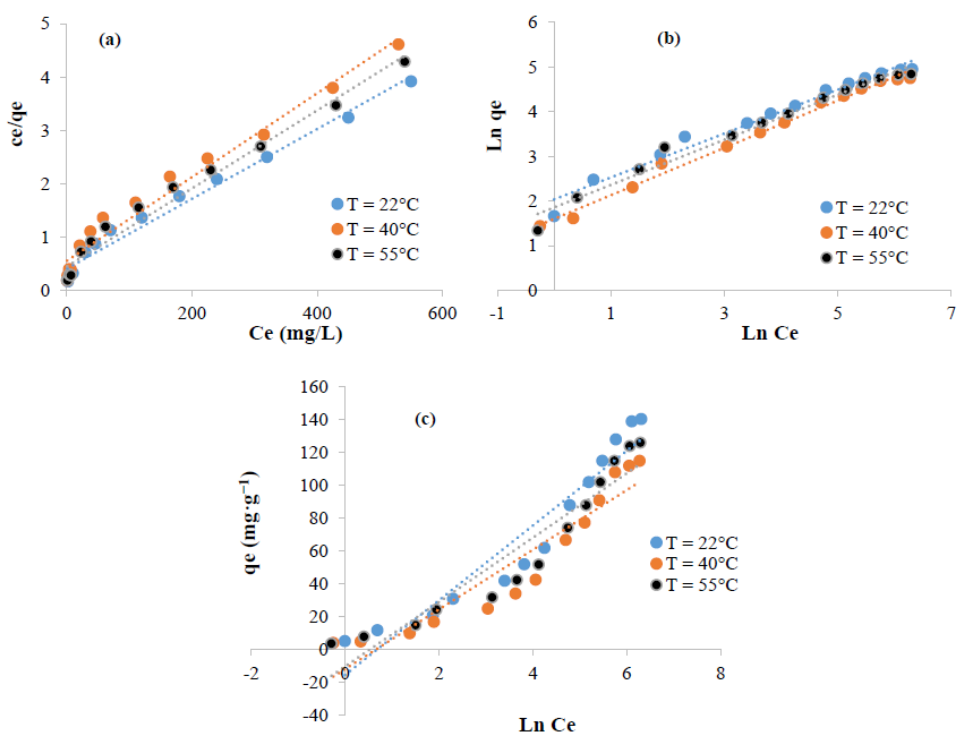
Figure 10. Linearized isotherms data for the adsorption of methylene blue on the surface of extracted cellulose: ( a ) Langmuir, ( b ) Freundlich, and ( c ) Temkin.